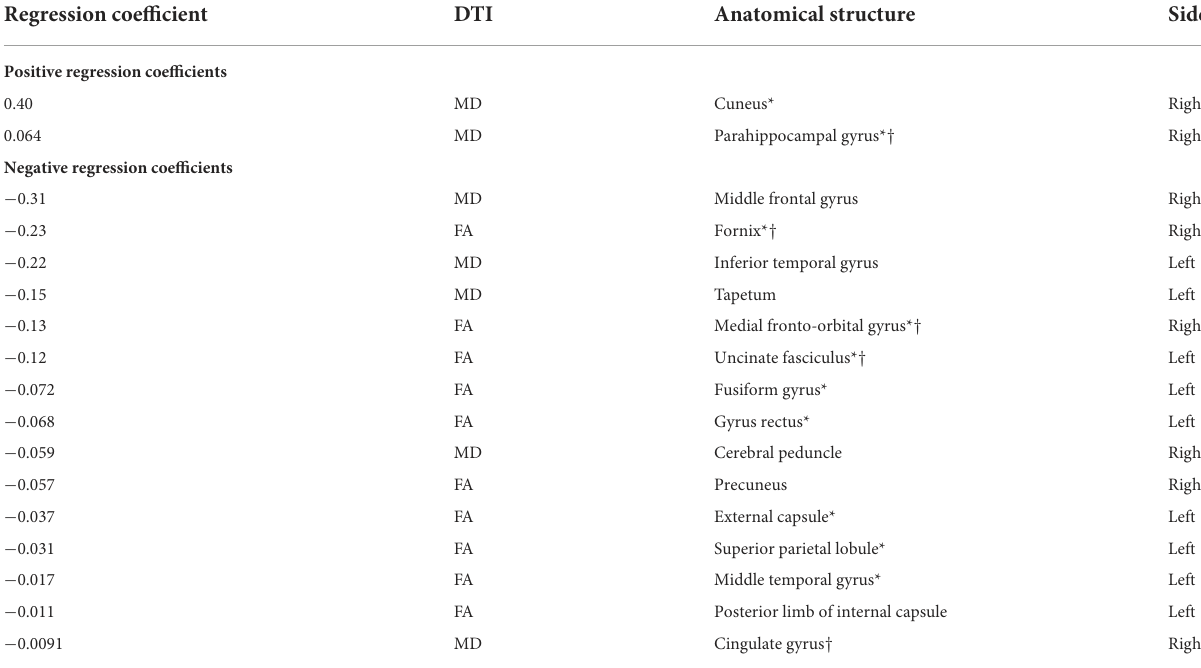
TABLE 4 Regression coefficients of the 17 factors selected by the LASSO regression analysis.